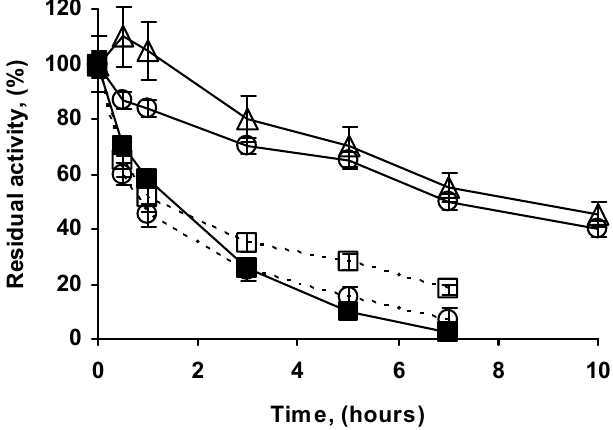
Figure 7. Inactivation courses of different MANAE-glutaraldehyde- β -gal preparations at pH 5 and 55 °C. Experiments were performed as described in Methods Section; the enzymes were immobilized on a support having 60 µ mol MANAE groups/g of support. All experiments were performed in triplicate and the values are given as mean value ± the experimental error. Dashed line, Open circles: Free β -gal; Dashed line, Open Squares: β -gal-MANAE immobilized at pH 5; Open Triangles. Solid line: MANAE-glutaraldehyde- β -gal immobilized at pH 7 at low ionic strength; Open Circles, Solid line: MANAE-glutaraldehyde- β -gal immobilized at pH 9 at low ionic strength; and Solid Squares, Solid line: MANAE-glutaraldehyde- β -gal immobilized at pH 8 at high ionic strength.